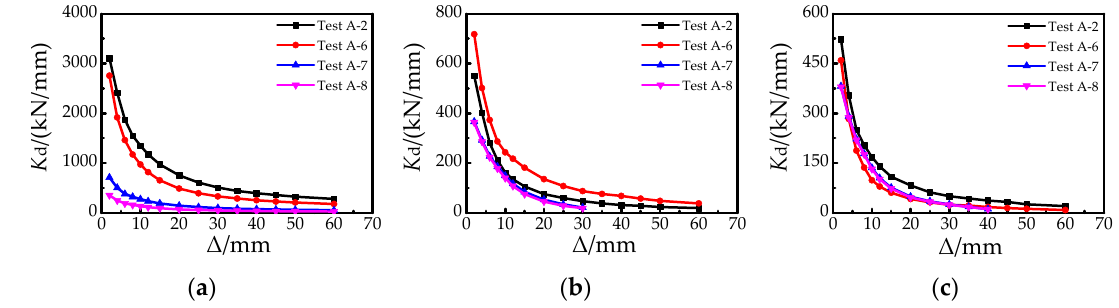
Figure 10. Stiffness degradation curves: ( a ) Pier top; ( b ) Node8; ( c ) Node18.